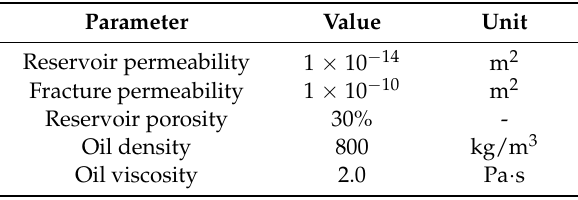
Table 1. Basic reservoir and fluid parameters in simulations for case 1~4.